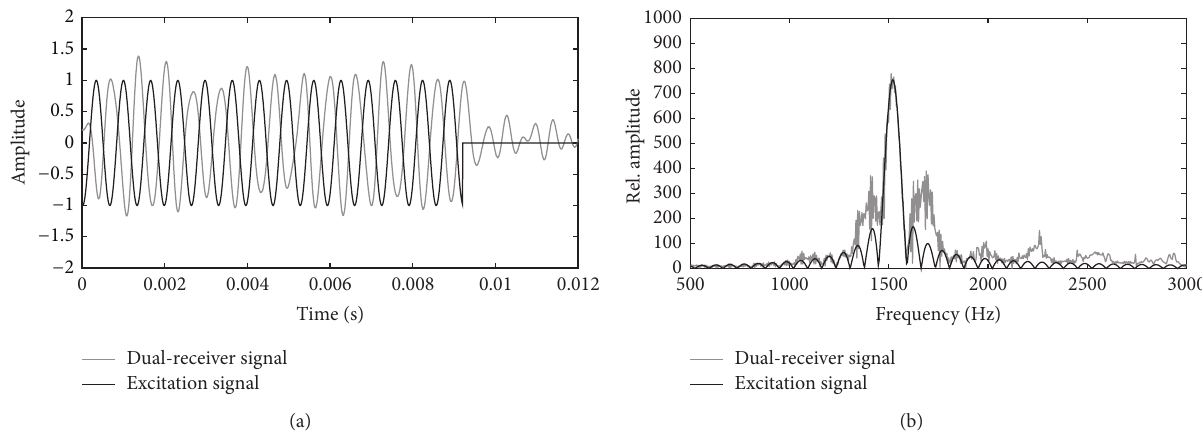
Figure 5: Simulation results of filtered signals in the dual-receiver mode. (a) Time-domain waveform, (b) frequency-domain